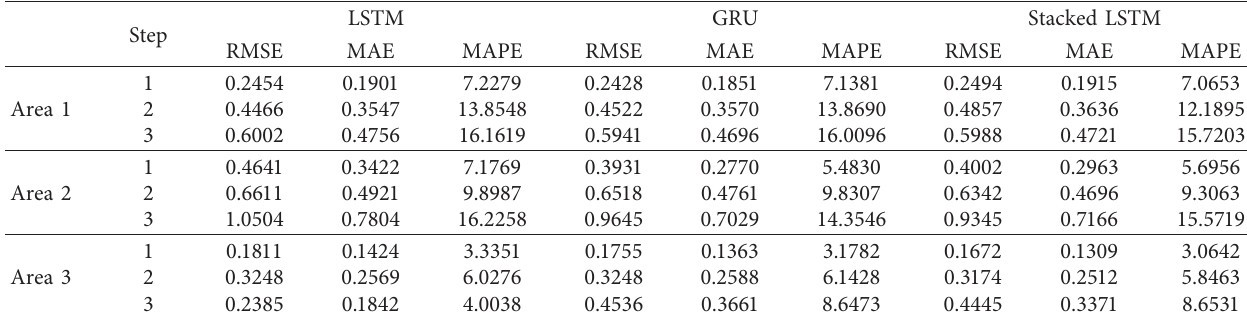
Table 7: Comparison of the proposed model and other models (b).